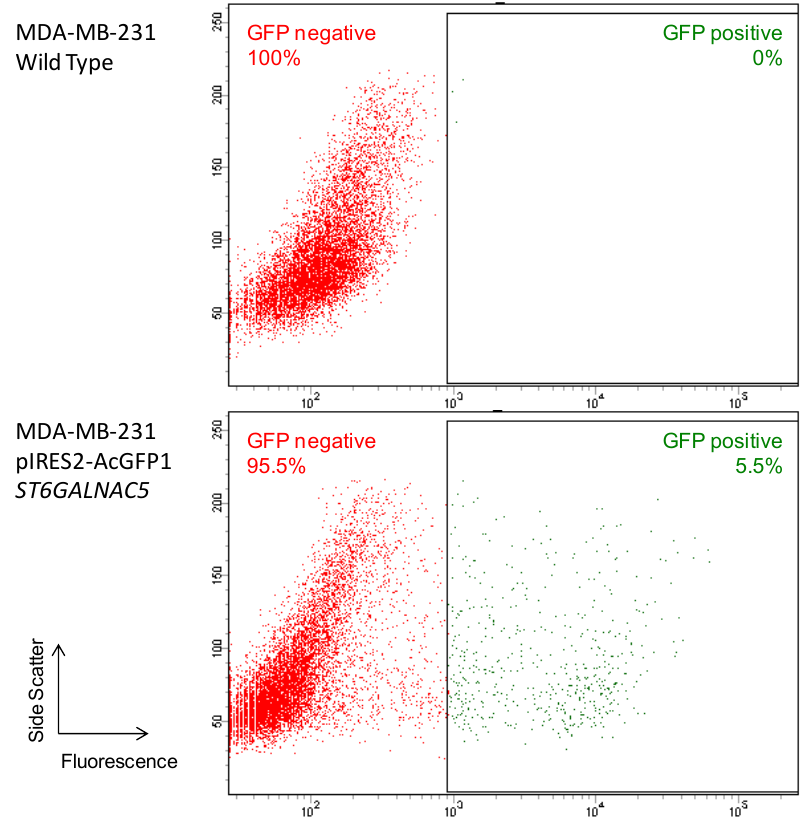
Figure 2. Cell sorting for GFP expression of the G418-resistant cell population. The G418-resistant cell population was sorted for GFP expression on an ARIA SORP flow